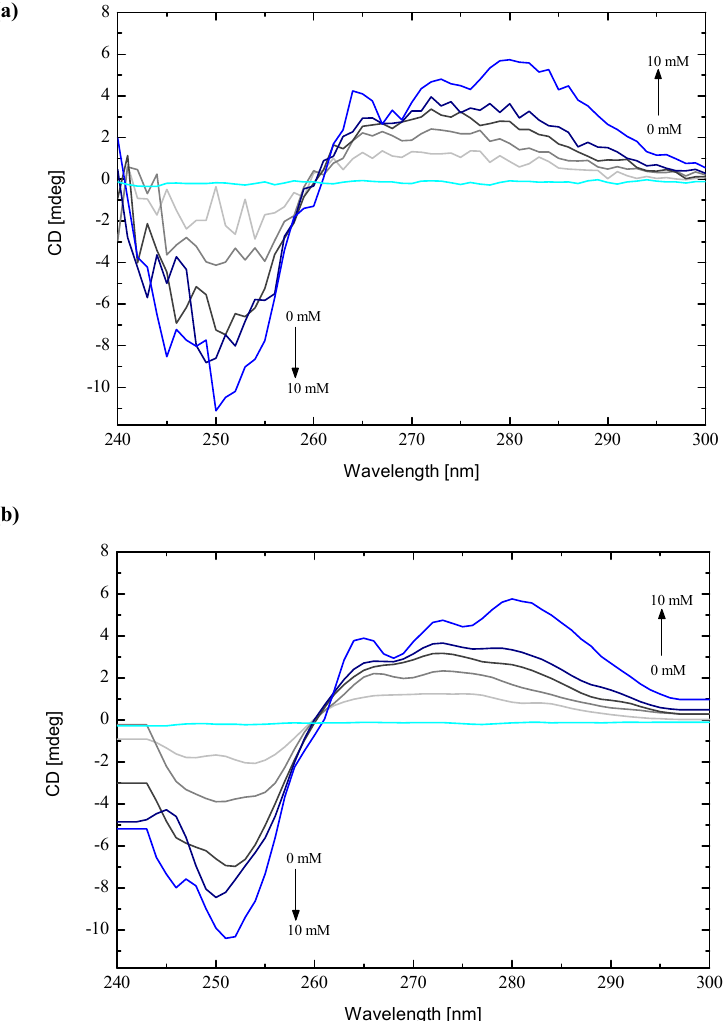
Figure 4. Selected circular dichroism spectra for aqueous solutions of mianserin hydrochloride with constant 0.6 mM concentration, together with growing content of heptakis (2,6-di-O-methyl)- β -cyclodextrin from 0.3 mM to 10 mM, with stoichiometry from 0.5:1 (light grey) to 1:16 MIA–DM- β -CD (blue line), and spectra for free DM- β -CD (cyan line). ( a ) Raw data and ( b ) smoothed with Savitzky–Golay filter [33,34] implemented as one of the smoothing options in the ORIGIN v. 7.0 software [35]. Based on this, one can assume that the A-ring and the B-ring of the MIA molecule are probably deeply inserted into the cavity of DM- β -CD with the dipole moment of chromo- phores (aromatic benzene rings) perpendicular to the Z-axis of DM- β -CD (Figure 1) for which the negative signal with a wavelength of 250 nm corresponds (Figure 4).